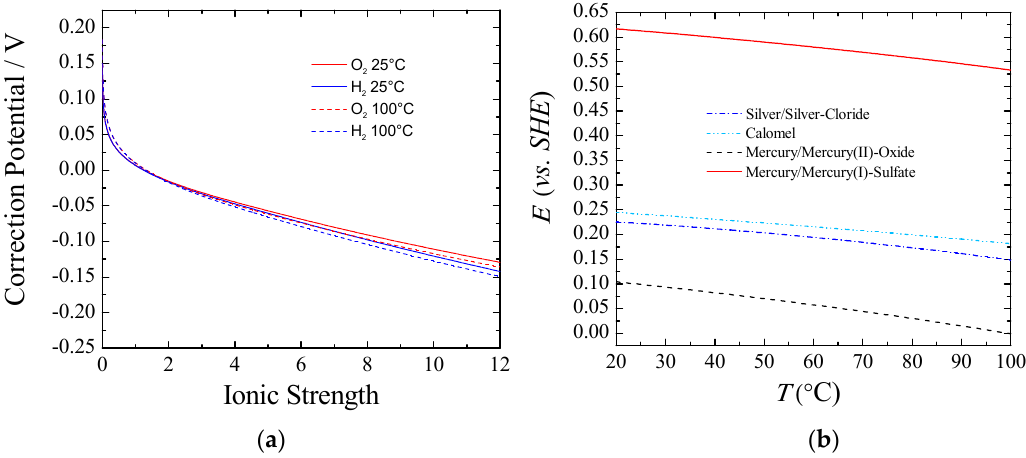
Figure 1. ( a ) Correction of the equilibrium potential from standard conditions vs. ionic strength of KOH. T = 25 and 100 °C; P = 1 atm.; ( b ) Potential vs. SHE for different reference electrodes against